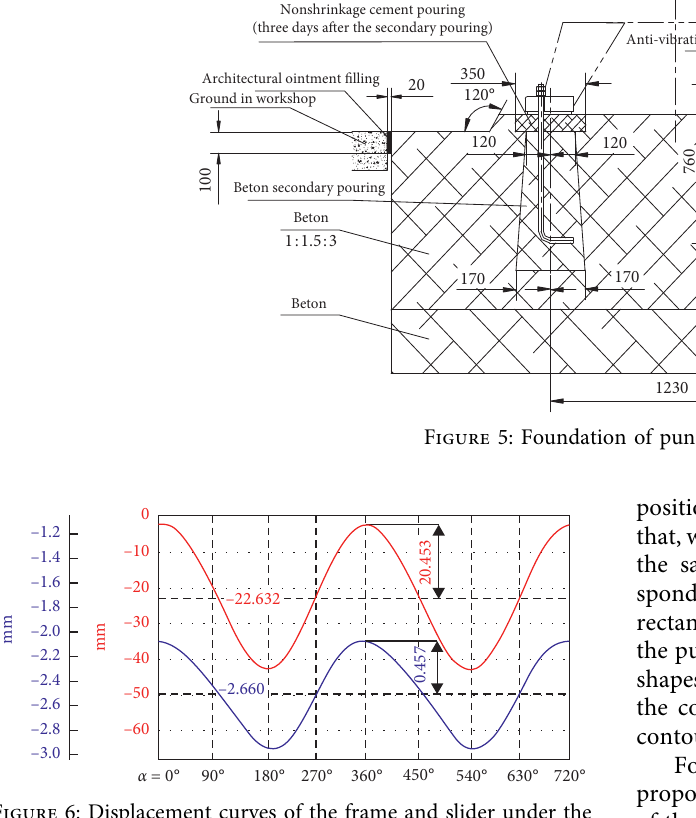
Figure 6: Displacement curves of the frame and slider under the condition of